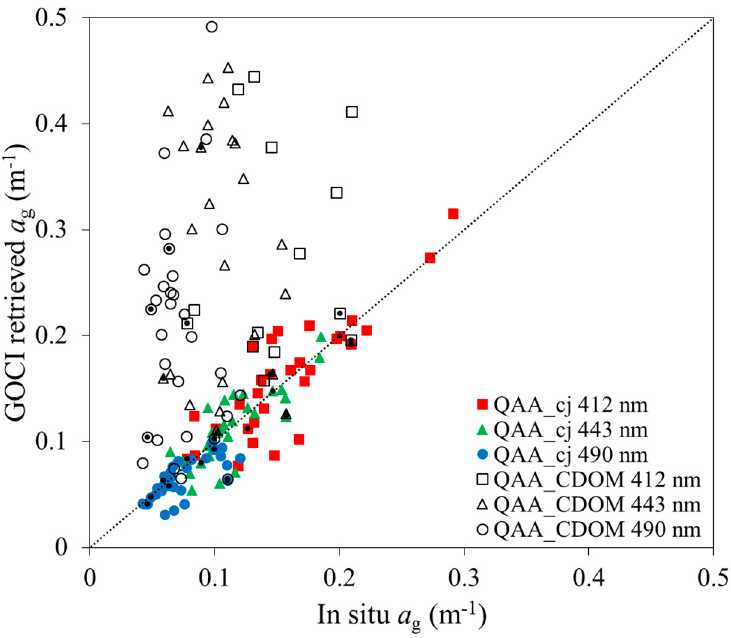
Figure 10. A scattering plot of GOCI retrieved a g ( λ ) vs. in situ a g ( λ ) data with using the QAA_cj algorithm (filled symbols) and QAA_CDOM algorithm (open symbols) at wavelengths of 412, 443, and 490 nm. The symbol with a filled dot inside represents the match point within the time window of ±3 h. Table 7. Comparison statistics of QAA_cj and QAA_v6 based on in situ dataset and GOCI-derived at